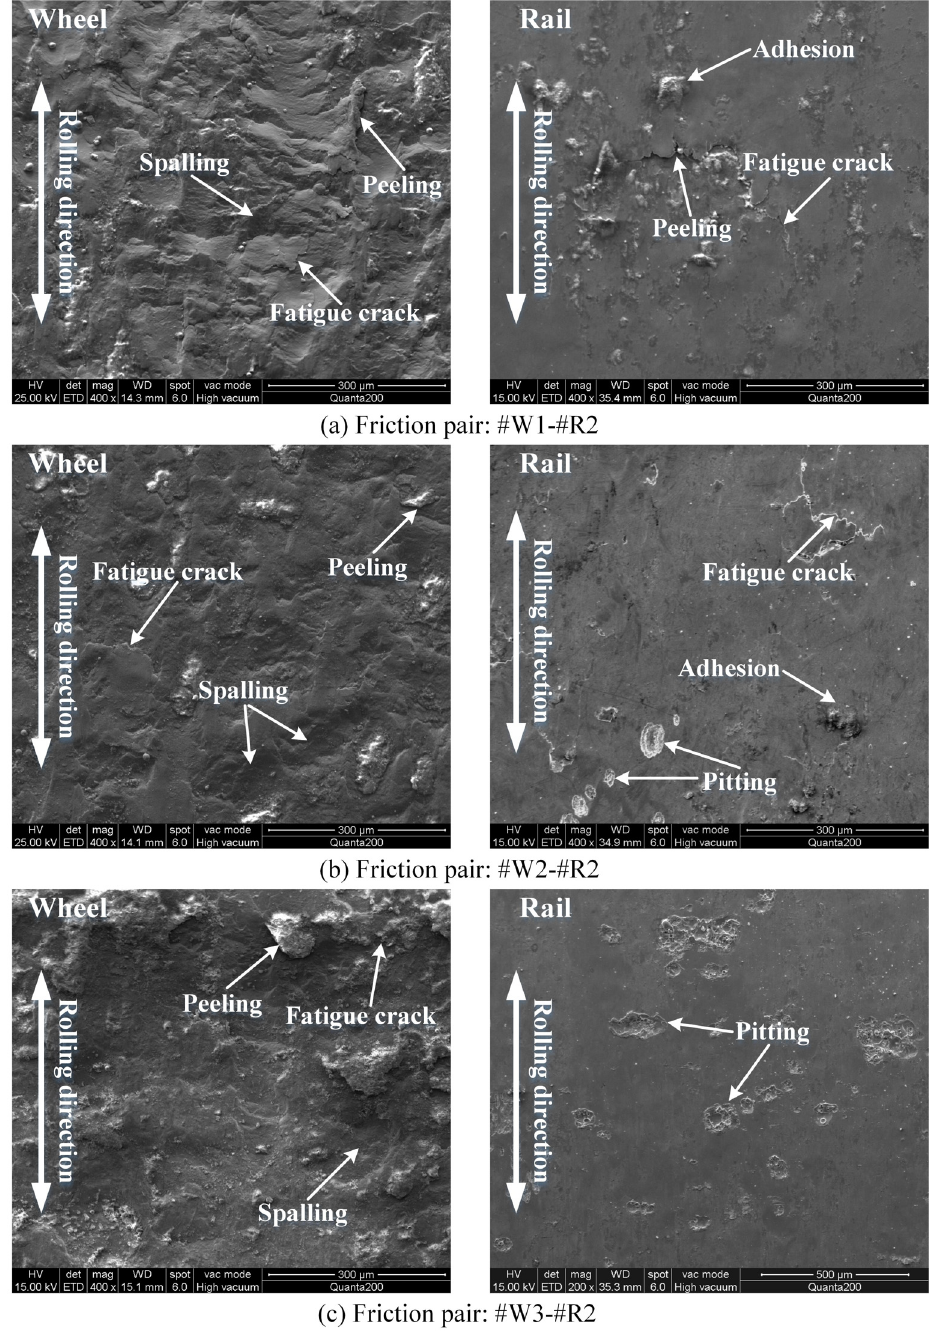
Figure 12. SEM micrographs of surface damage of the wheel/rail discs under different friction pairs: